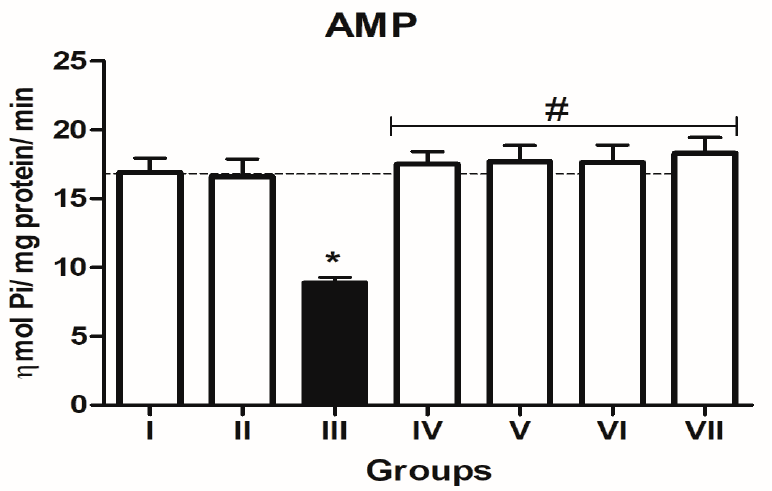
Figure 3. 5 (cid:48) -nucleotidase (AMP as substrate) activity in platelets of L-NAME-stressed rats treated with tiger nut and walnut supplemented diets. Data are presented as mean ± SEM ( n = 10). The bars with various symbols are statistically different ( p < 0.05). * represents a significant difference from the control (I) group. # represents a significant difference from the ED (III) group (one-way ANOVA followed by post hoc Tukey, *, # denote p < 0.05; Key: Group I: Normal control placed on a basal diet; Group II: Positive control placed on a basal diet/L-NAME/Viagra (5 mg/kg/day); Group III: ED-induced group placed on a basal diet/L-NAME (40 mg/kg/day); Group IV: Processed TN supplemented diet (20%)/L-NAME; Group V: Raw TN supplemented diet (20%)/L-NAME (20%); Group VI: Processed WN supplemented diet (20%)/L-NAME; Group VII: Raw WN supplemented diet